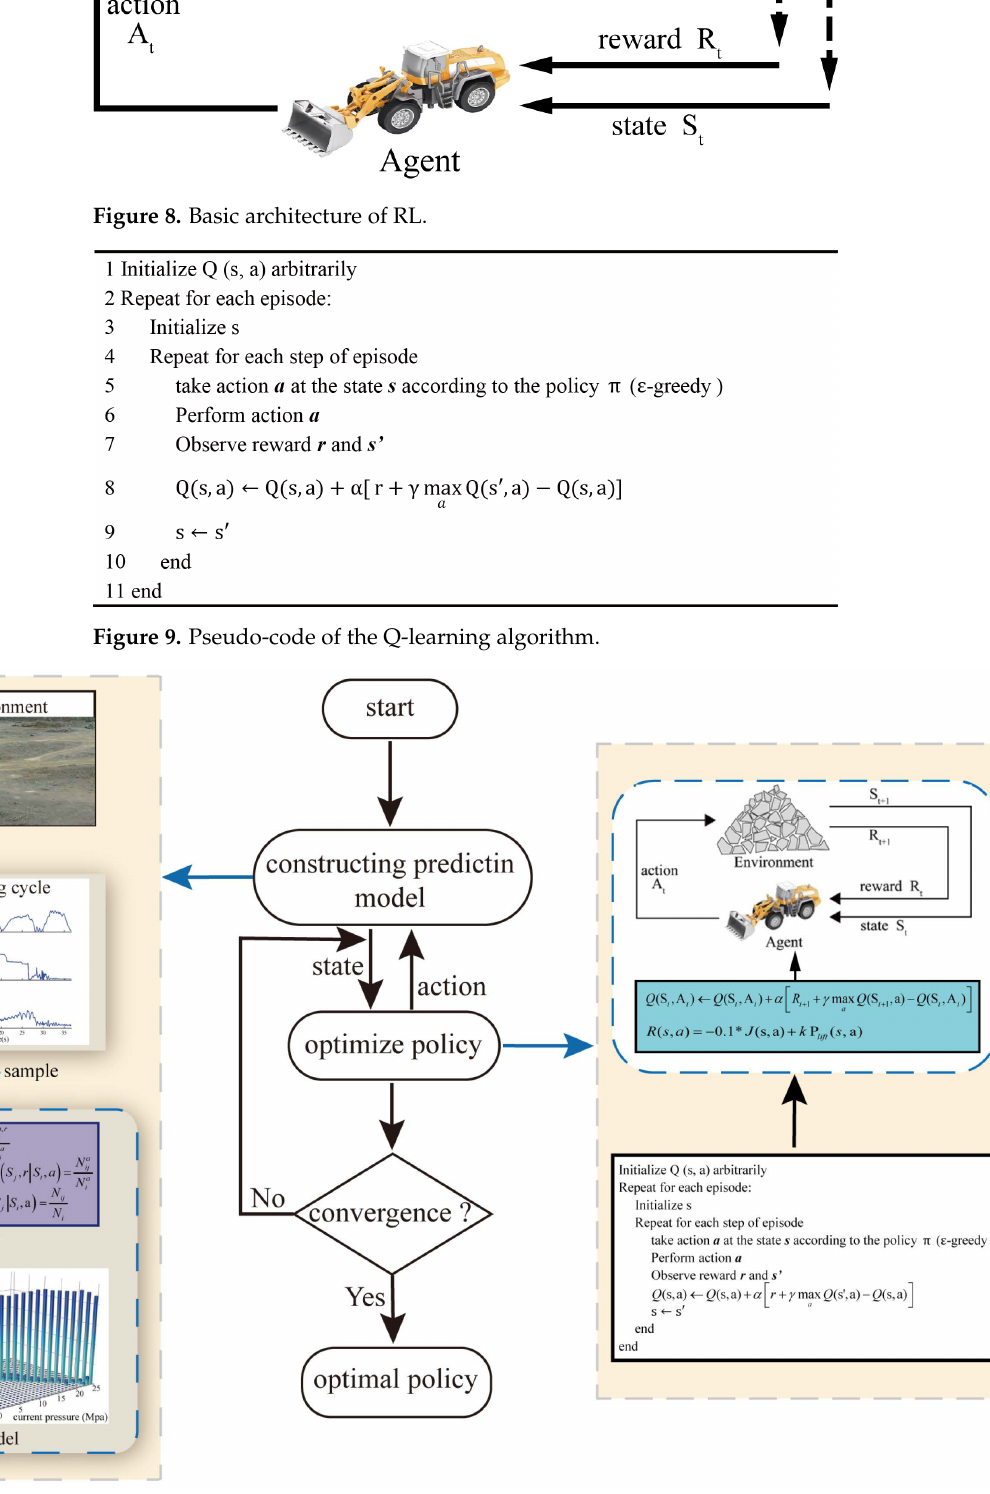
Figure 10. Prediction model-based Q-learning architecture in automatic